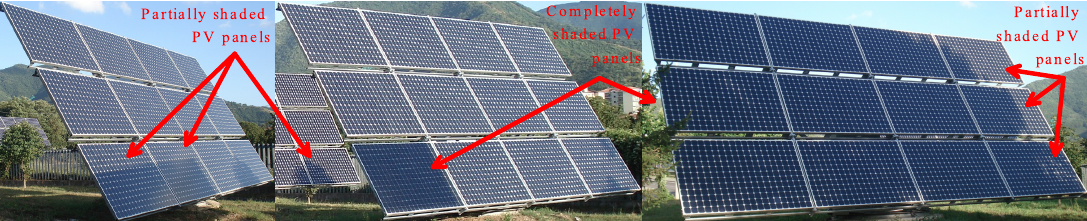
Figure 1. Shading profiles affecting commercial PV systems in urban